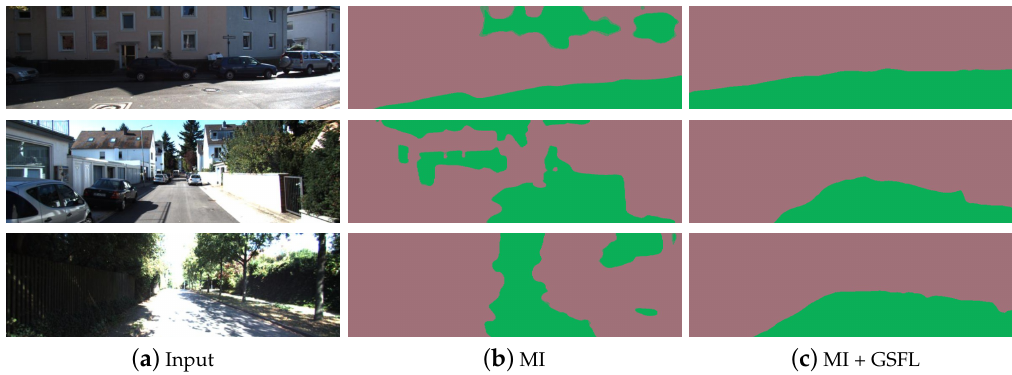
Figure 1. From left to right are: the input image, the ground segmentation result obtained only using the mutual information loss (MI), and the result by joint learning which uses the ground self-learning loss (GSFL). It can be seen that after adopting the geometric prior, the ground segmentation results have been enhanced.